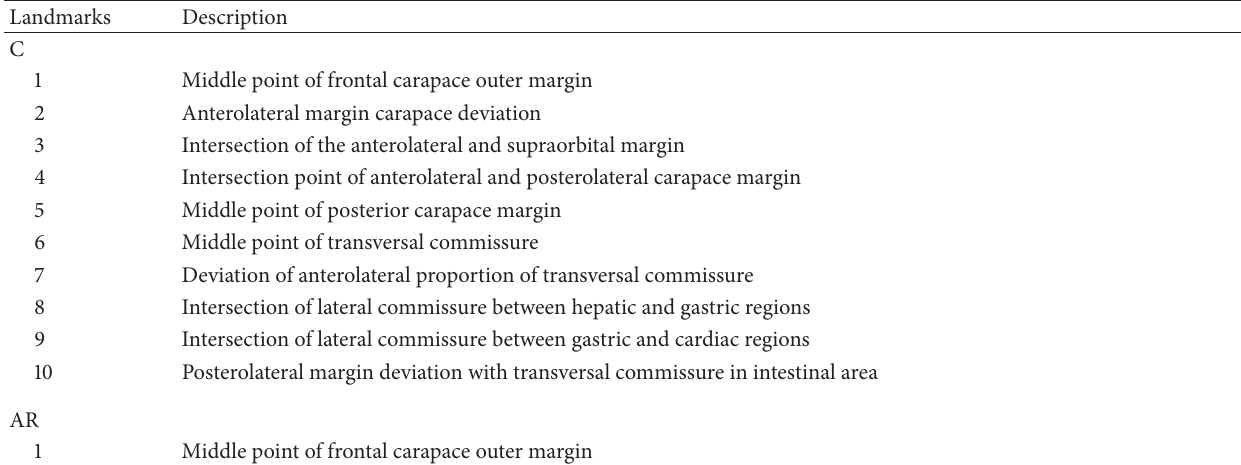
Table 1: Ucides cordatus (Linaeus, 1763): list of landmarks descriptions used in sexual dimorphism characterization. Dorsal area of carapace— C; Anterior region of cephalotorax—AR and Outer face of major